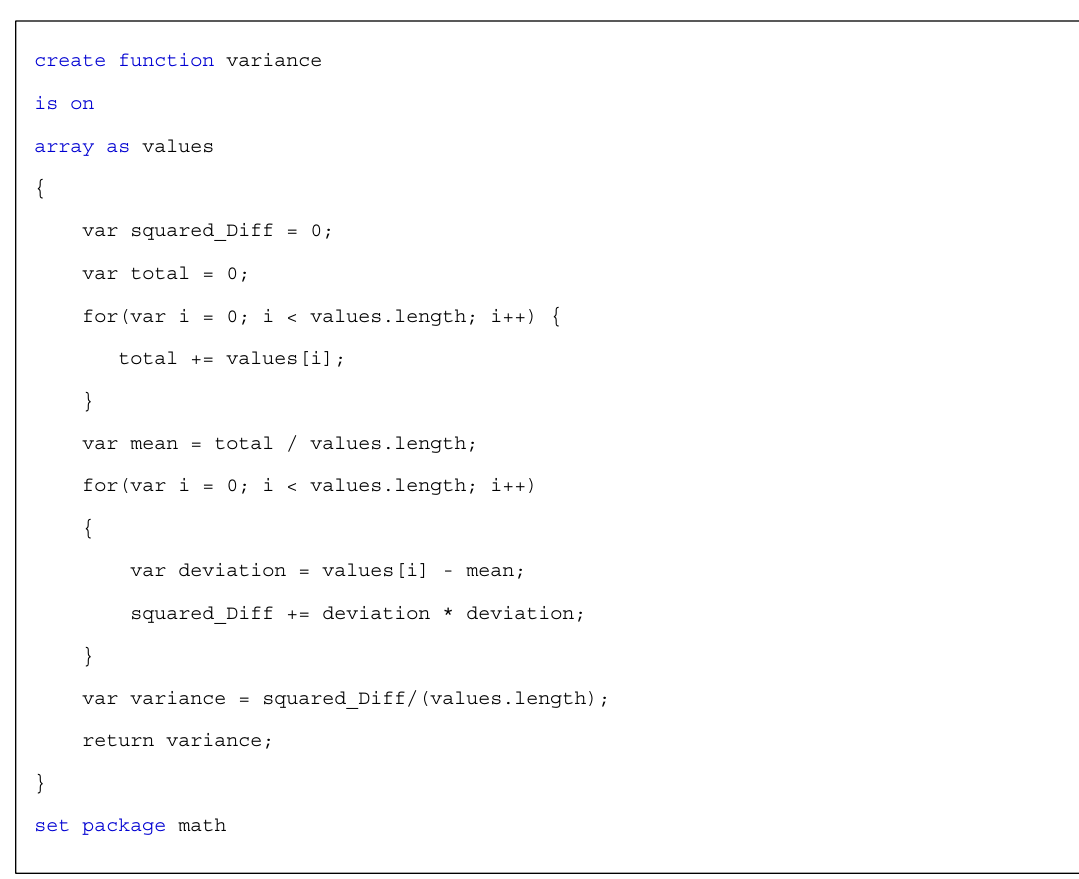
Scheme 11. Example of creating a custom aggregation function using JavaScript.